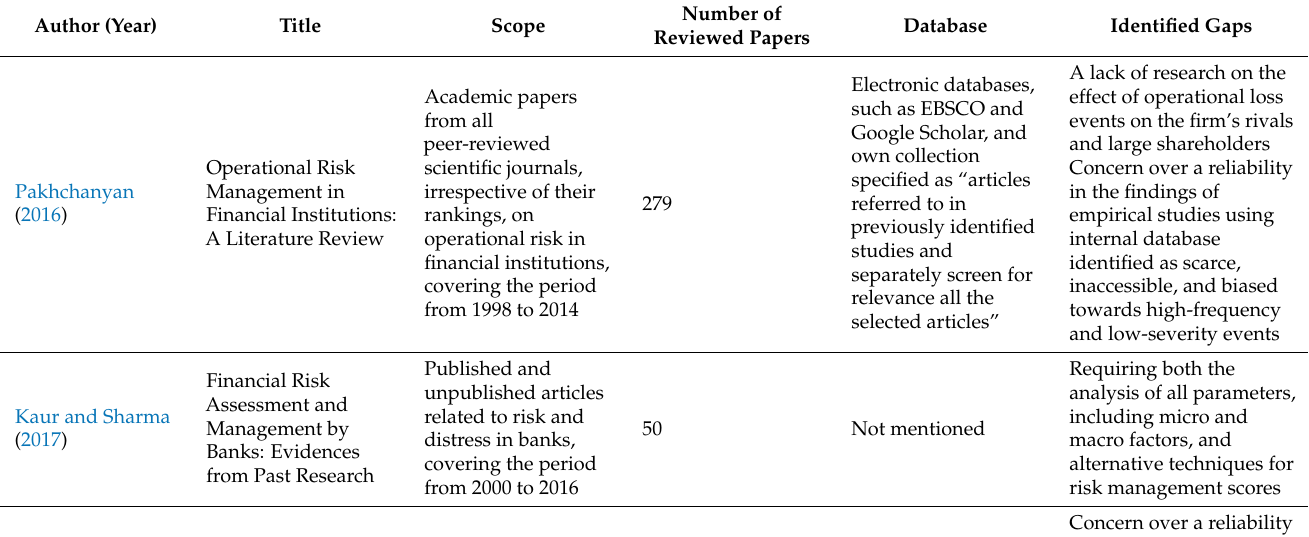
Table 1. Literature review articles in banking operational risk